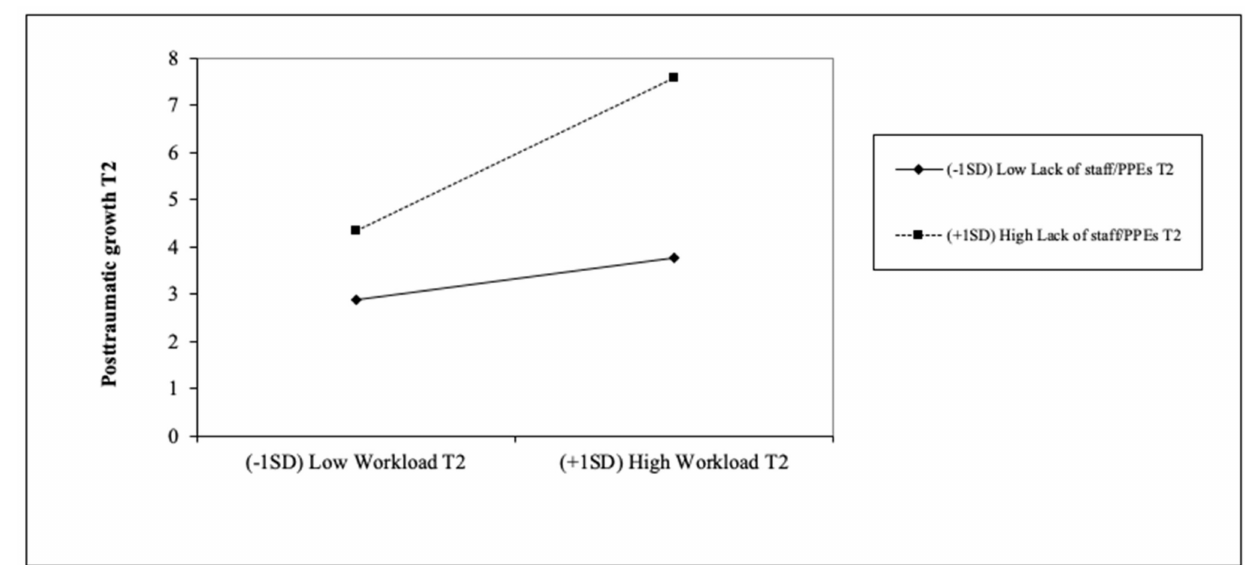
Figure 3. Interaction effects of workload and lack of staff/PPE in T2 in predicting posttraumatic growth in T2. Note : PPE = Personal Protection Equipment; T2 = second wave of COVID-19 (December